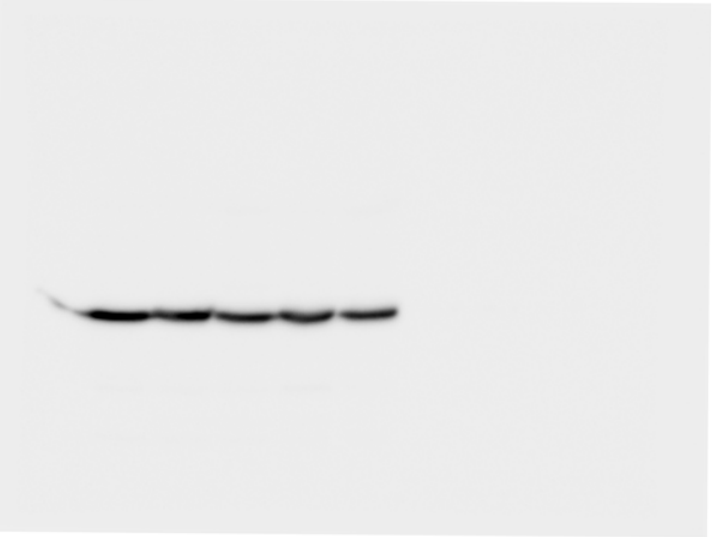
Fig 10. Raw blot for HEK293-TLR2 GAPDH